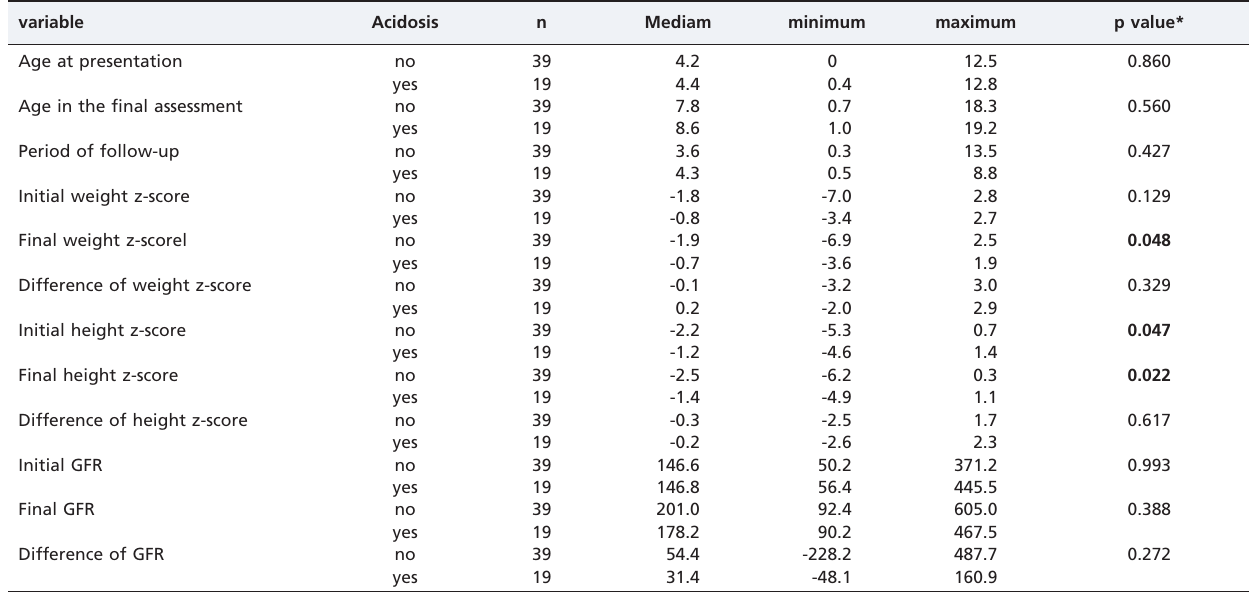
Table 8 - Comparison between the group without acidosis and the group with acidosis regarding to age at presentation, age in the final assessment, period of follow-up, initial/final weight z-score, difference of weight z-score, initial/final height z-score, difference of height z-score, initial/final GFR, and difference of GFR.